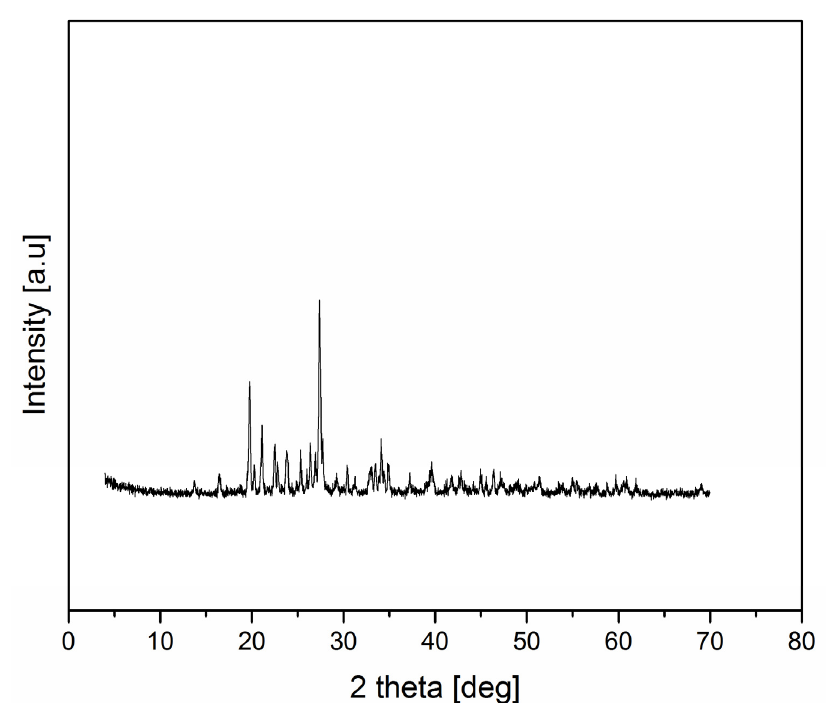
Figure 3. The XRD spectrum of lab-synthesized mPSS.